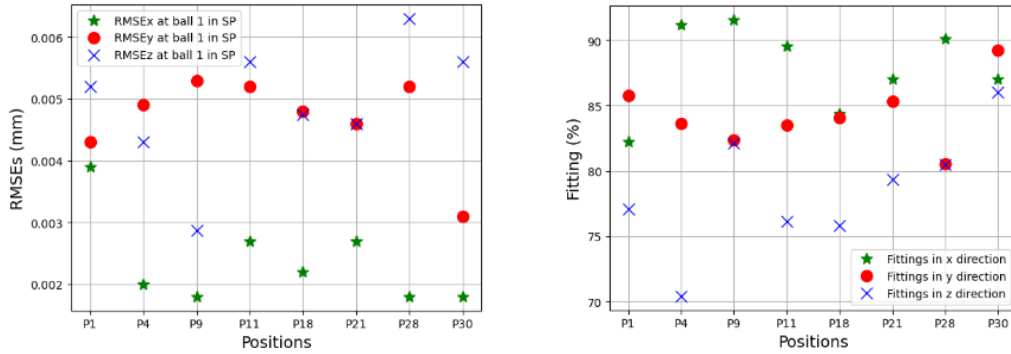
Figure 20. RMSEs and fi tt ings of seven positions at ball 4 in the long process (LP).